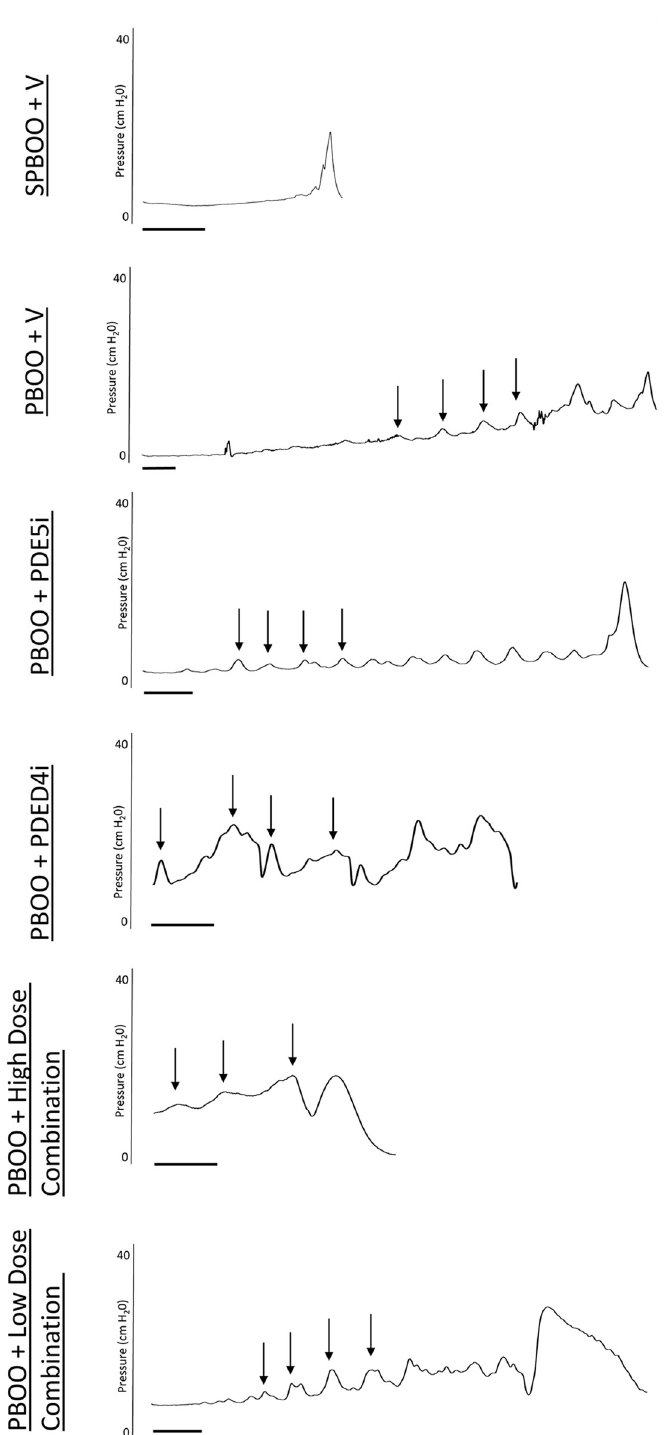
Fig 3. Examples of anesthetized cytometry bladder pressure for each group: Sham partial bladder outlet obstruction (PBOO) and vehicle treatment (SPBOO + V) (A), PBOO with vehicle (PBOO + V) (B), PBOO with PDE5i treatment (C), PBOO with PDE4i treatment (D), PBOO with high dose combination treatment (E), and PBOO with low dose combination treatment (F). The scale bar indicates 1 minute. Arrows indicate example non- voiding